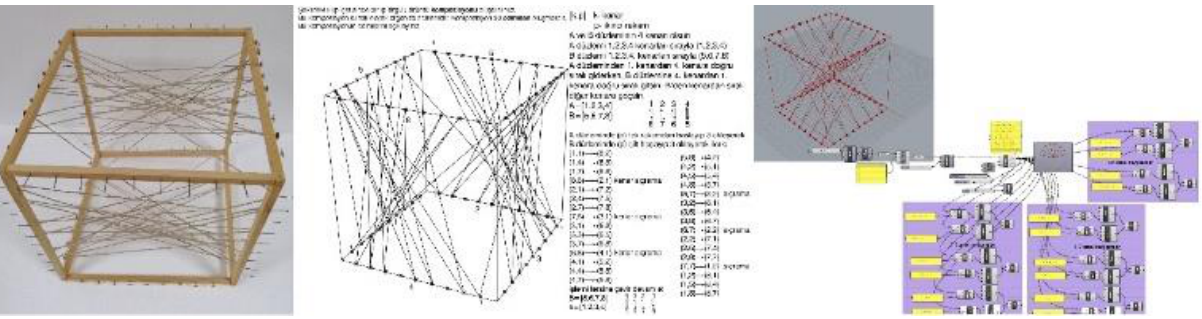
Figure 6. A computational thinking process carried out at KTU CODE FAB